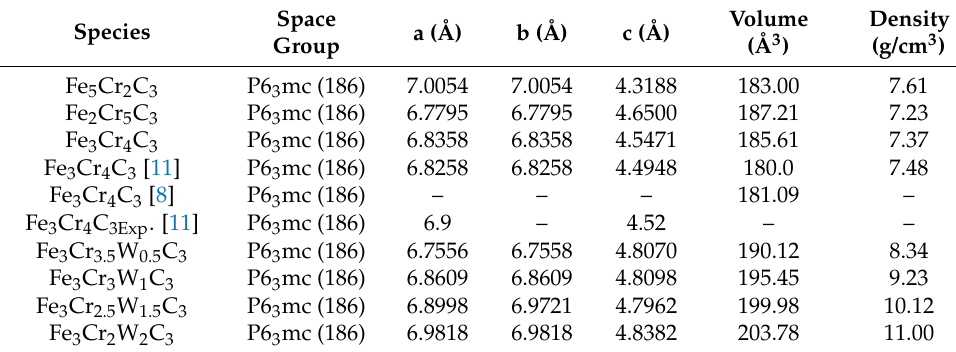
Table 1. The lattice parameters of different M 7 C 3 carbides. Species